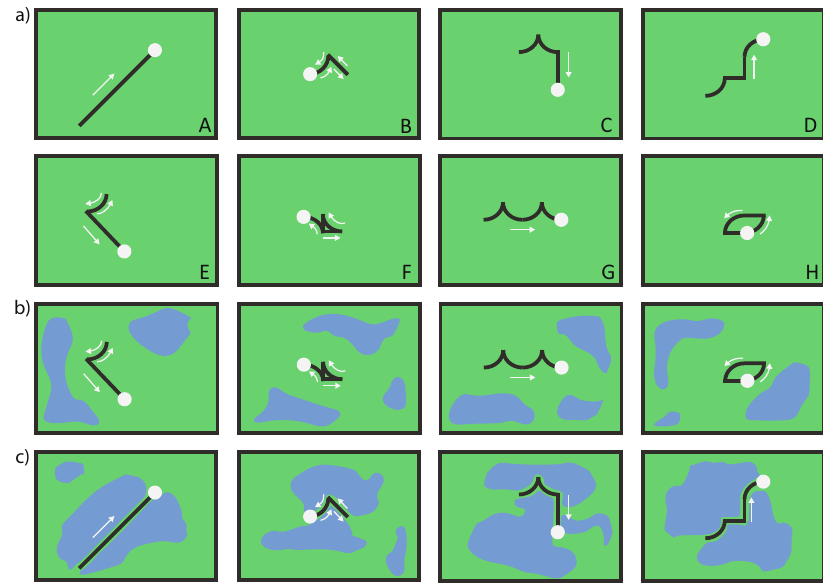
Fig. 1 Conceptual illustrations of trajectories used in Studies 1 – 3 and the Explanation Control. See https://osf.io/ehb48/ for full stimuli set and videos. The trajectories used were a subset of paths built by sequentially chaining combinations of sixteen primitive movements. Paths were sorted into eight movement classes that captured high-level properties of the movements: (A) maximally ef fi cient paths ( n = 2 paths), (B) paths that retrace themselves back to their origin ( n = 3), (C) paths that move toward multiple quadrants ( n = 3), (D) paths that move toward only one quadrant ( n = 3), (E) paths that partially retrace themselves ( n = 3), (F) paths that intersect themselves, but do not start and end in the same position ( n = 3), (G) paths that have repeated components that form a pattern ( n = 3), and (H) paths that do not retrace themselves, but start and end in the same position ( n = 3). a Example paths used in Study 1. b Example paths from the unbordered condition in Study 3. c Example paths from the bordered condition in Study